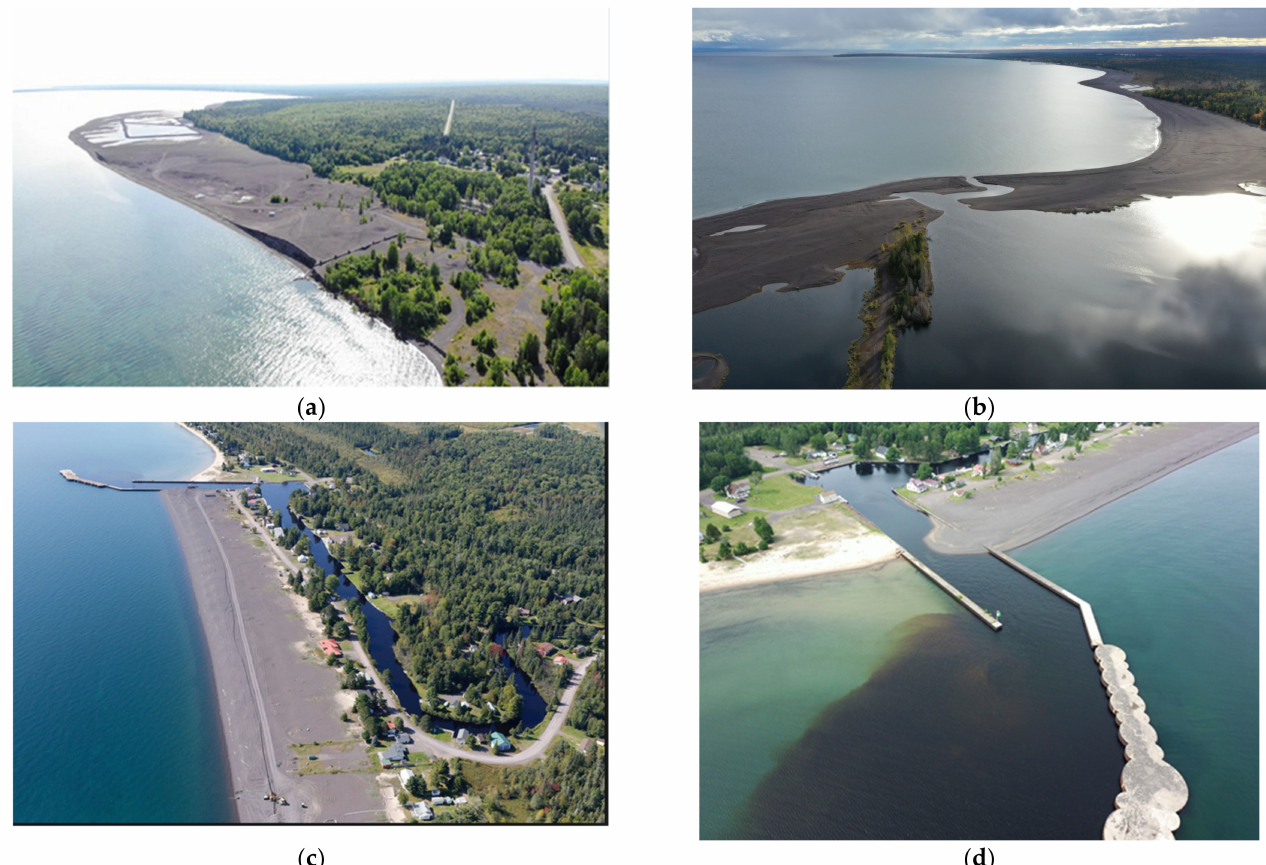
Figure 4. Drone shots (MTRI) characterize the 2019 shoreline of Grand (Big) Traverse Bay: ( a ) remains of original tailings pile with the town of Gay in the background; ( b ) Coal Dock, trees mark the dock portion; ( c ) relative width of stamp sand (dark beach) and natural beach (southern white string beach) at the Traverse River Harbor; ( d ) stamp sands overtopping the Traverse River Seawall; note humic-stained dark water flowing out of the harbor into the